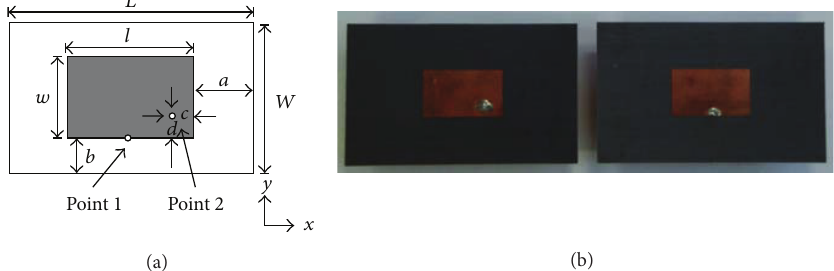
Figure 1: Configuration of the microstrip patch antennas: (a) 𝐿 = 98 mm, 𝑊 = 60 mm, 𝐻 = 2.4 mm, 𝑤 = 20 mm, 𝑙 = 34 mm, 𝑎 = 32 mm, 𝑏 = 20 mm, 𝑐 = 7 mm, and 𝑑 = 5 mm and (b) the fabricated antennas.